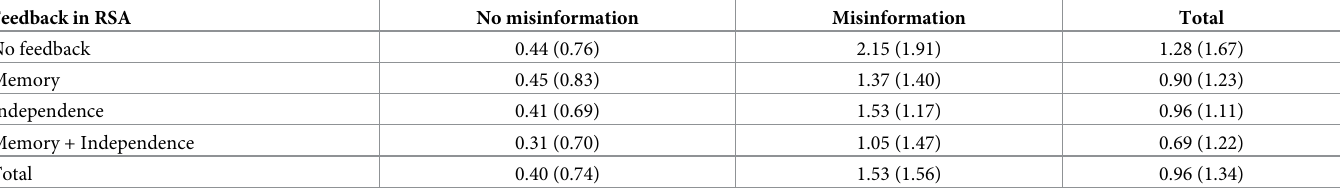
Table 3. Means ( SD s) of number of answers consistent with misinformation across experimental conditions in Experiment 3 (range: 0–6).